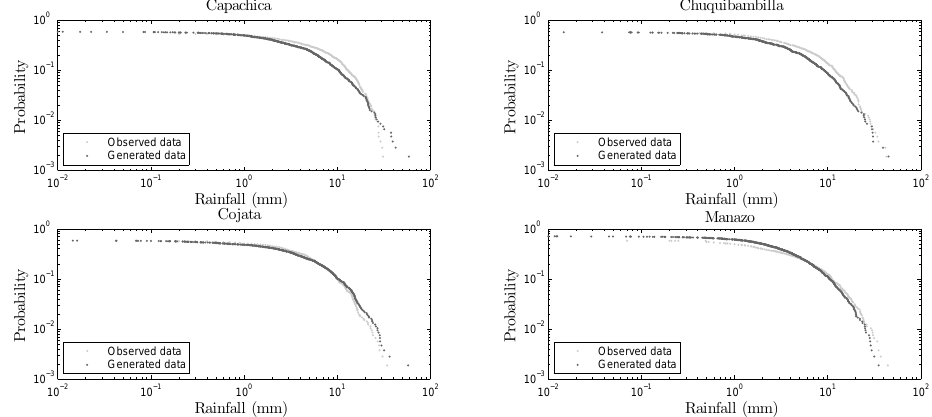
Figure 16. Exceedance probability plots for the rainy season (November–March) over an 8-year period of observed and simulated TRMM measurements for stations Capachica, Chuquibambilla, Cojata and